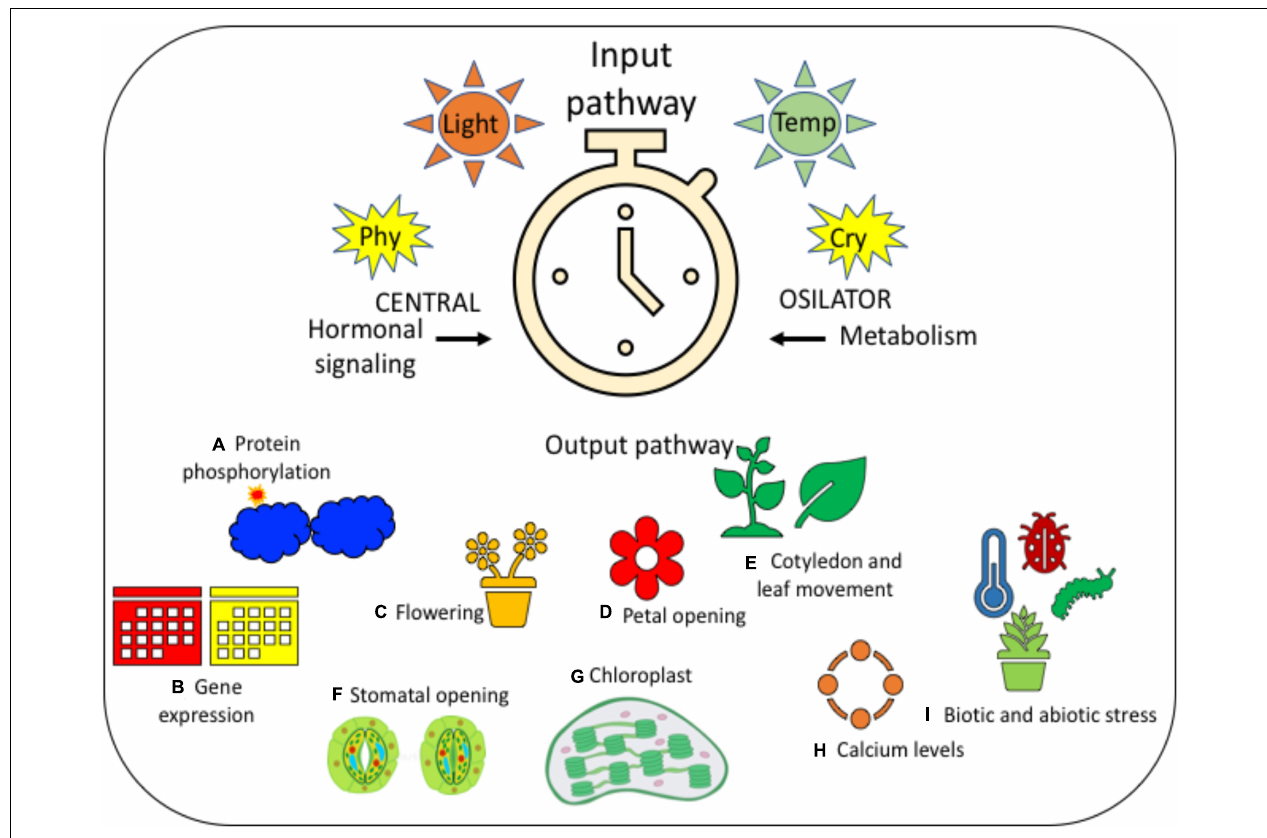
FIGURE 2 | It is a diagrammatic representation of the circadian rhythm for providing a clear idea on the same. It has three different stages, such as (i) input pathway that contains light and temperature, which is then followed by (ii) central oscillator, in the presence of photoreceptors, such as PHY and CRY; further leading to the (iii) output pathway, which consists of many different physiological and developmental processes, such as (A) protein phosphorylation, (B) gene expression, (C) flowering, (D) petal opening, (E) cotyledon and leaf movement, (F) stomatal opening, (G) chloroplast, (H) calcium levels, and (I) biotic and abiotic stress. All these processes indicate the step-by-step variations that take place in every plant during the changes in photoperiodic